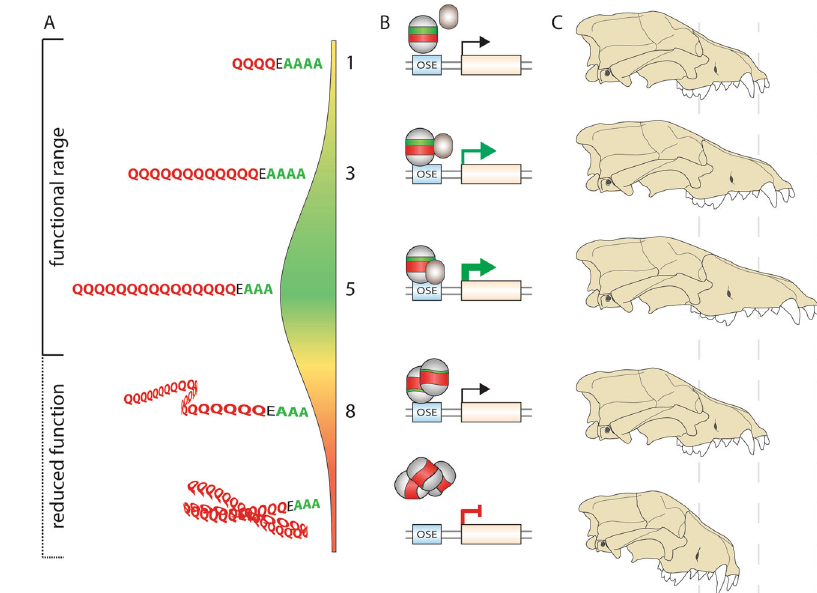
Fig. 2 RUNX2 QA repeat length determines protein transactivation. Schematic of RUNX2 QA repeat mode of action. a QA repeat lengths form a “ goldilocks ” range that determines function. Short repeats are less functional than medium length repeats, while expanded repeats form protein aggregates, reducing function. b Hypothetical mechanism of action where increasing repeat length promotes interactions with transcriptional co-factors, increasing gene expression (arrows) before hitting a critical threshold inhibiting activity. c QA repeat-driven changes to protein transactivation and downstream gene expression is suggested to fi ne-tune craniofacial length in several groups of mammals and can cause disease when in excess. OSE osteocalcin-speci fi c element that occurs in osteogenic gene